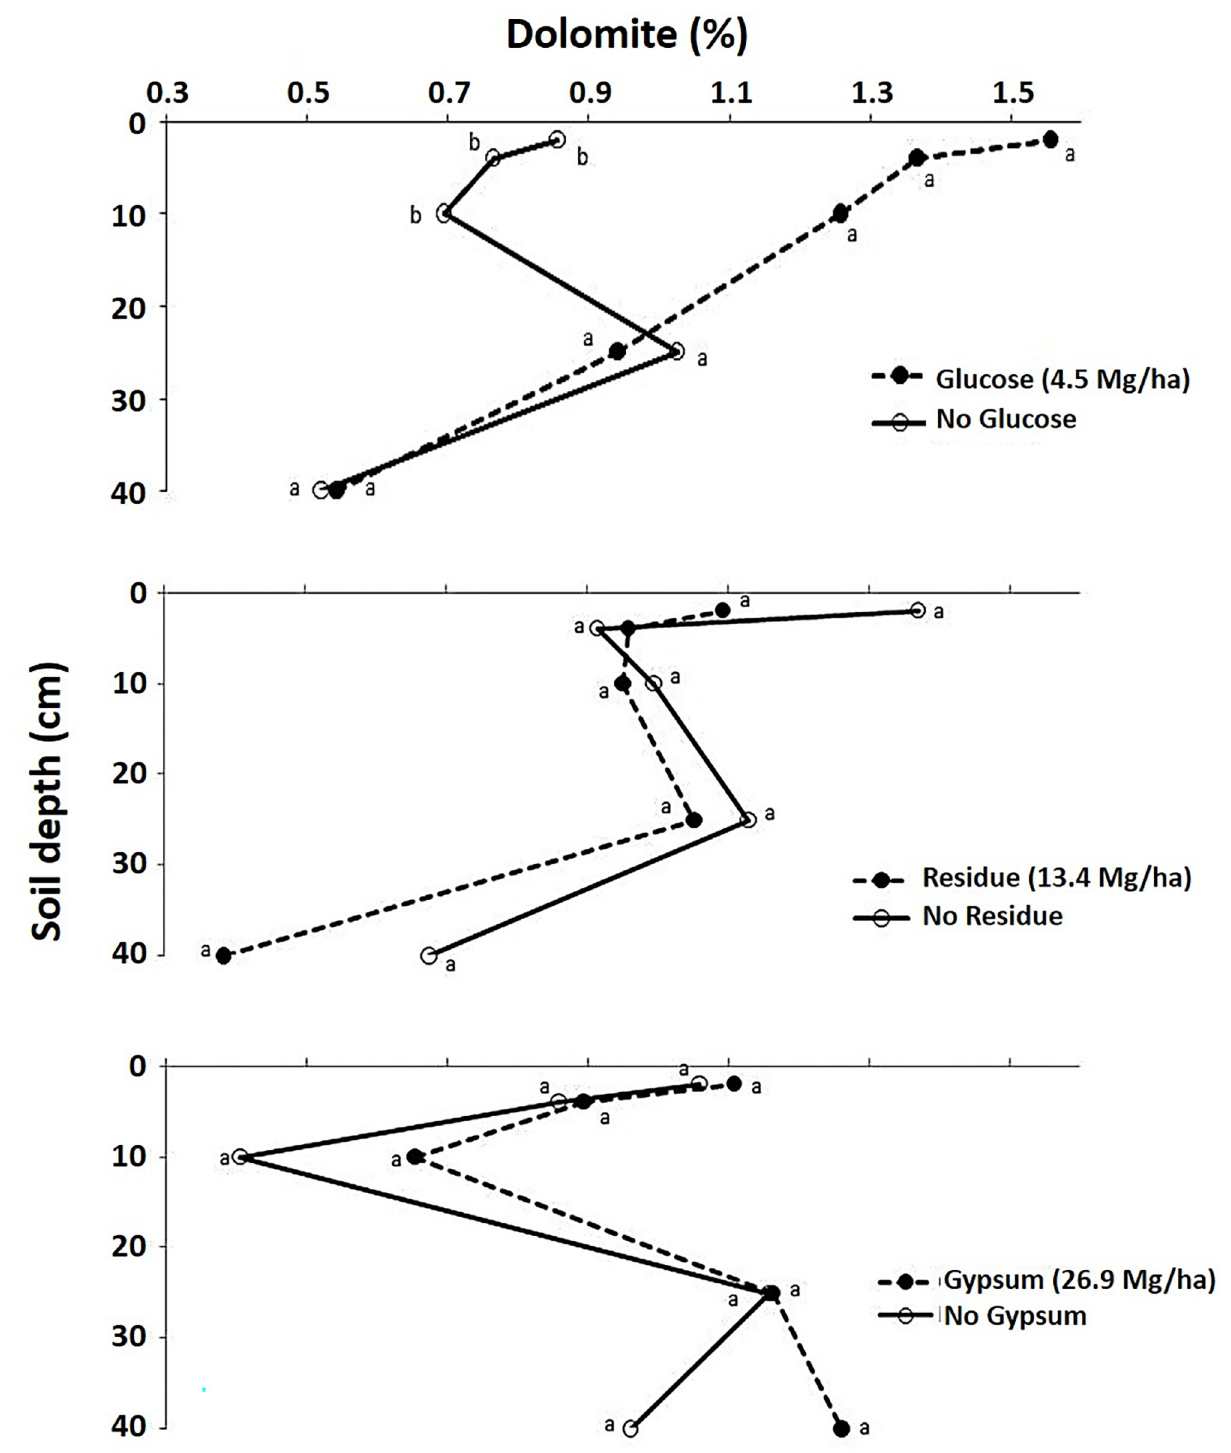
Fig 4. Effect of glucose, residue and gypsum addition on dolomite (%) in different Hoytville soil layers. Means with the same letter within same layer are not statistically different (P < 0.10).